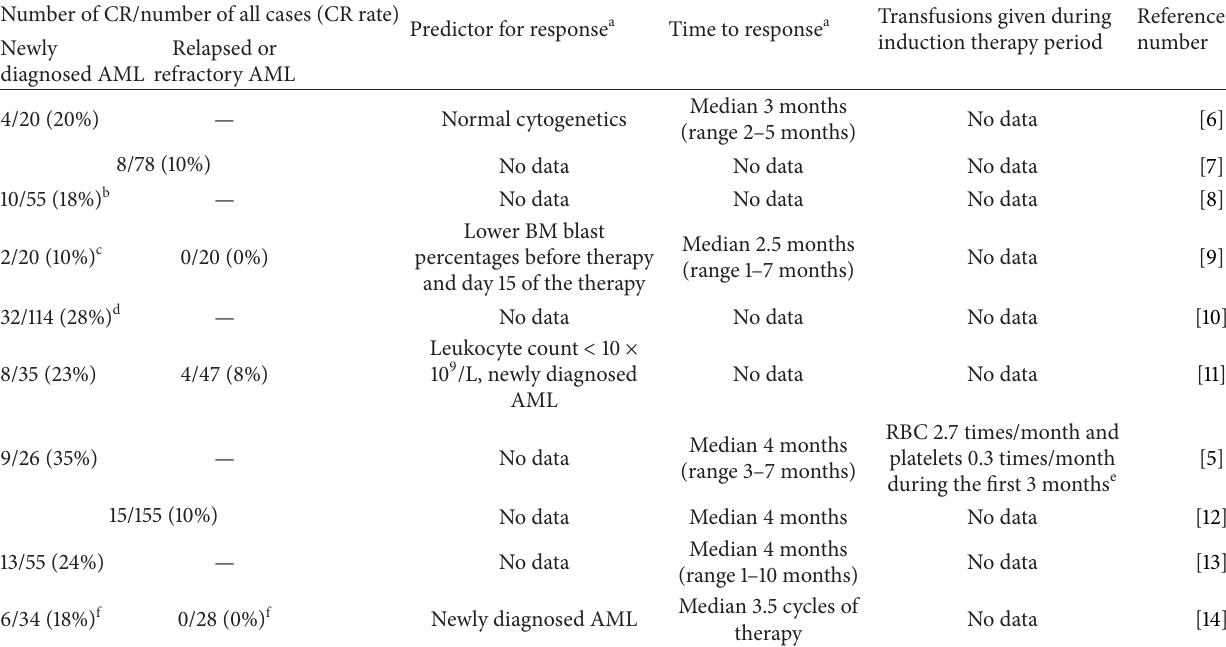
Table 1: Azacitidine therapy for AML in the